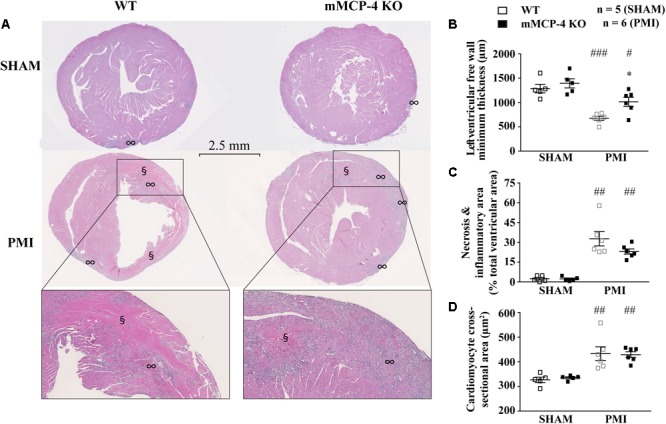
Representative H&E staining of heart sections 3 days following LAD coronary artery ligation (A). § notes eosinophilia sites, ∞ marks inflammatory cell invasion sites. The minimal thickness at the infarct site (B), eosinophilic and inflammatory regions (C) and cardiomyocyte cross-sectional area (D) were measured from the same images and quantified. (#: PMI vs. SHAM, ∗: mMCP-4 KO vs. WT, one-way ANOVA with multiple comparisons Holms-Šidak post-test).